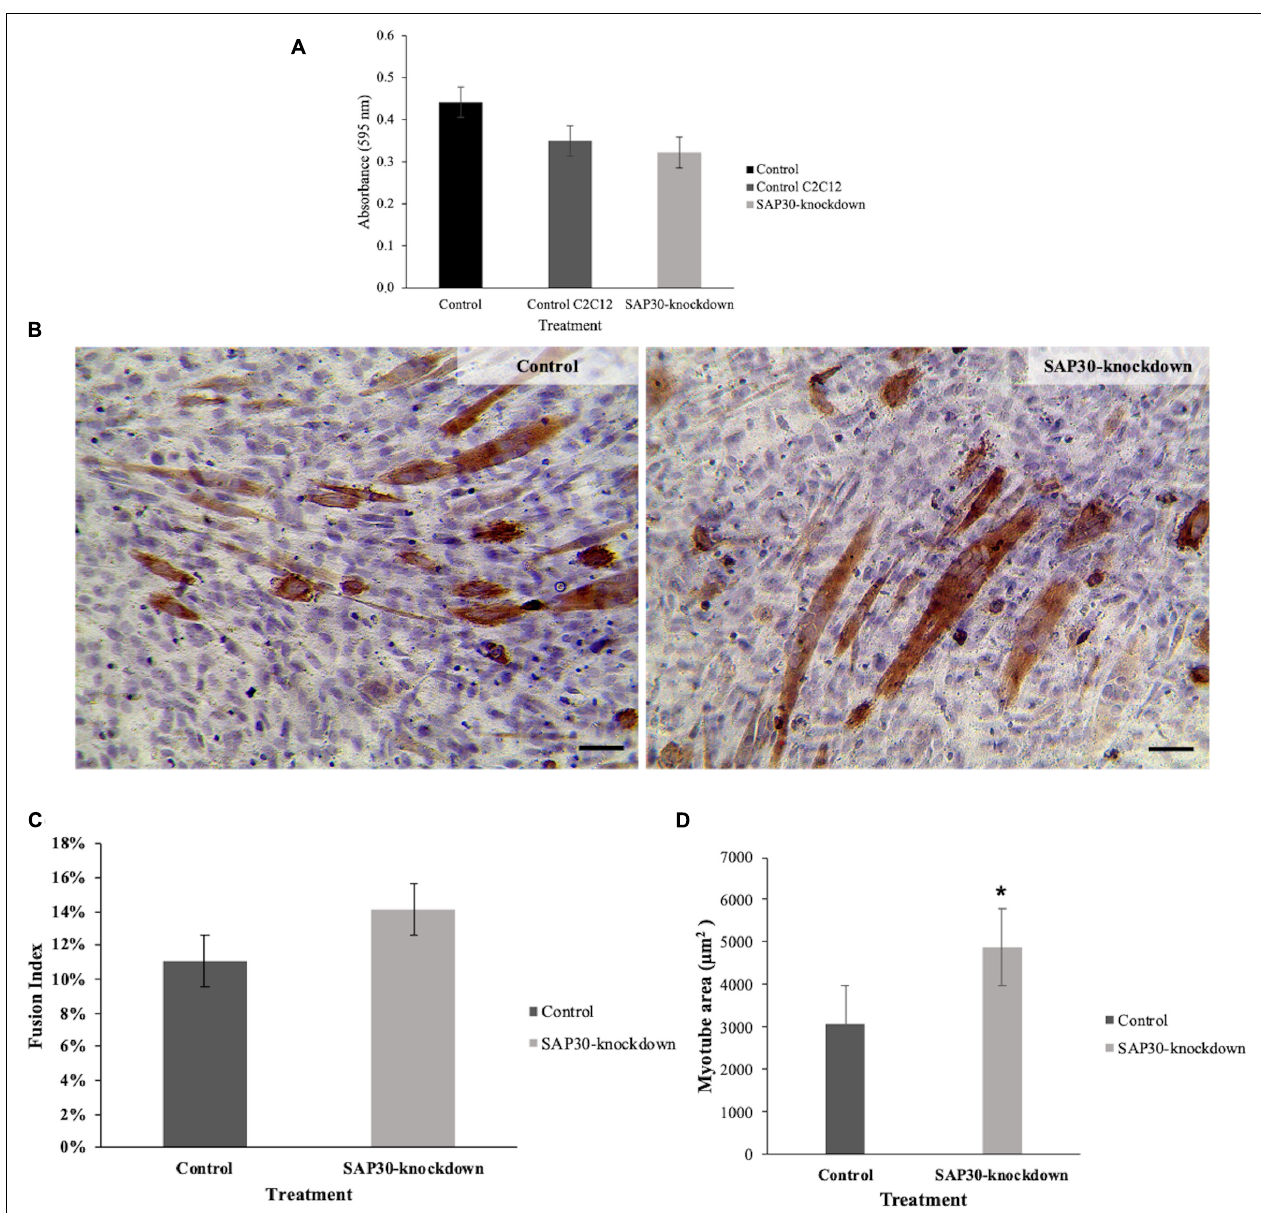
FIGURE 1 | Cell viability index and morphological effects of C2C12 cells transfected with SAP30 siRNA and control. (A) Graph representing the cell viability index determined by the MTT assay performed in C2C12 cells after 3 days of transfection with SAP30 siRNA or siRNA control. (B) Representative image of MF20 immunocytochemistry result in C2C12 culture after 3 days of transfection with siRNA control and SAP30-knockdown. Scale bar = 100 µ m. (C) Fusion index of MF20-positive cells transfected with siRNA control and SAP30 siRNA after 3 days in DM. (D) Myotube area of C2C12 cells transfected with the siRNA control and SAP30-knockdown. Significant values * p <